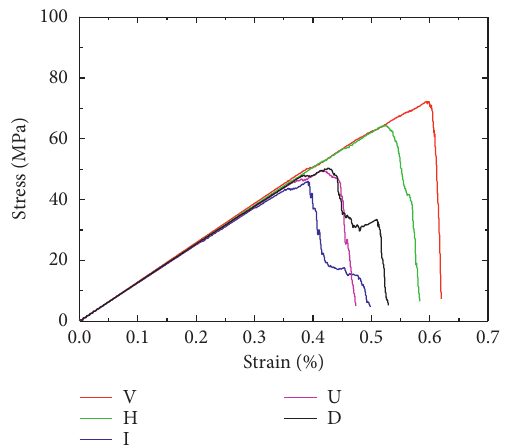
Figure 14: Stress-strain curves of rock samples with different boreholes arrangement forms.